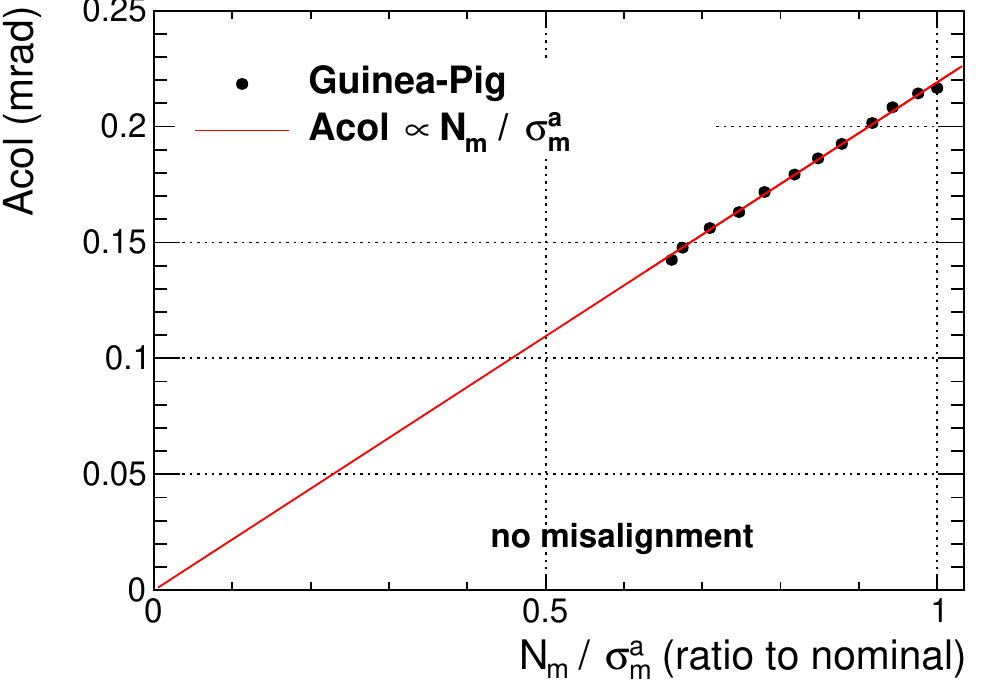
Figure 14 . The acollinearity variable Acol predicted by Guinea-Pig simulations at each step of the ramp-up, as a function of the average bunch intensity divided by the average bunch length to the power 0 : 72, for leading-order Bhabha events. The result of a (cid:12)t of an a(cid:14)ne function is shown as the full